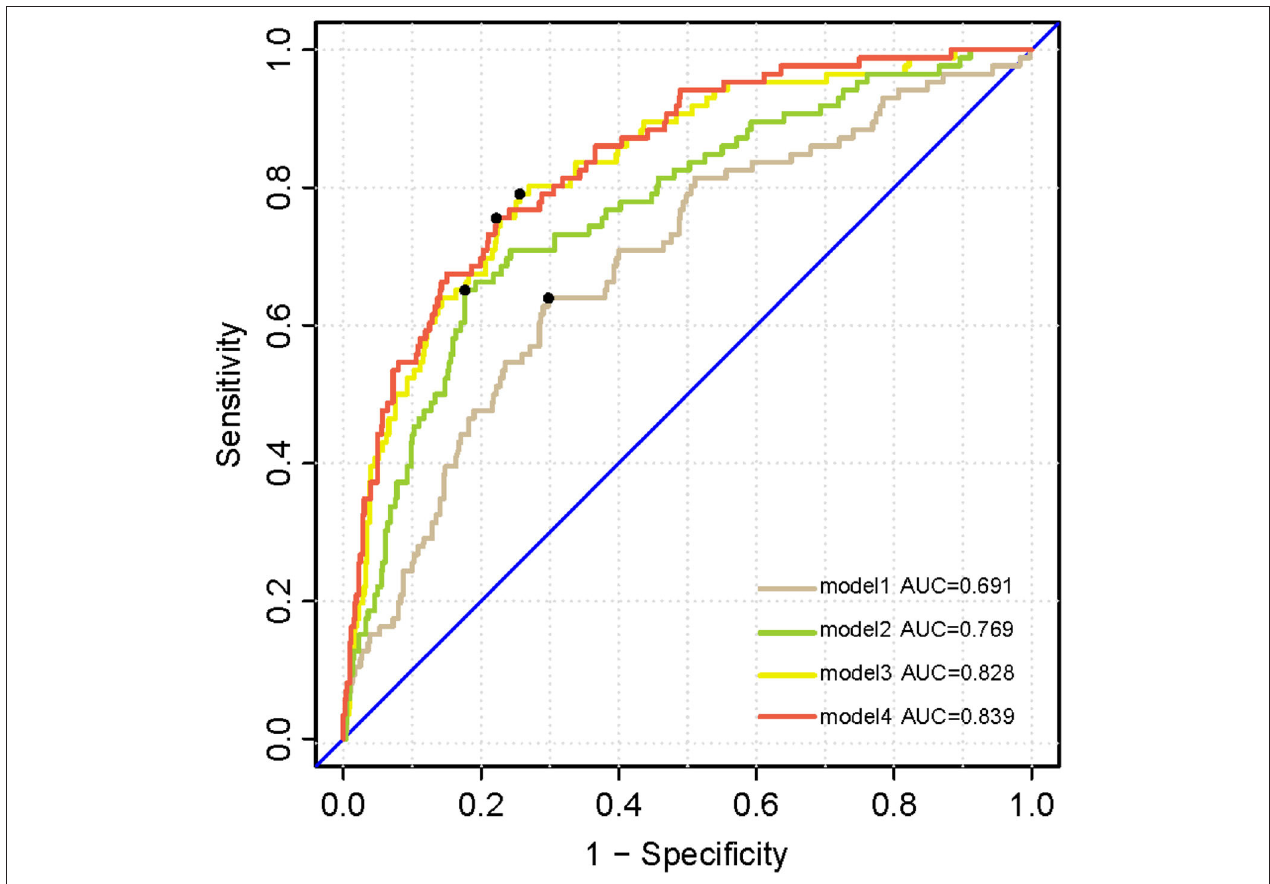
FIGURE 6 | Receiver operating characteristic analysis curves denoting CSF biomarkers and plasma p-tau 181 for progressing to dementia. Model 1 includes age, sex, years of education, and APOE ε 4 genotype. Model 2 additionally includes plasma p-tau 181. Model 3 additionally accounting for CSF biomarkers including A β 1-42, t-tau, and p-tau. All above factors are contained in model